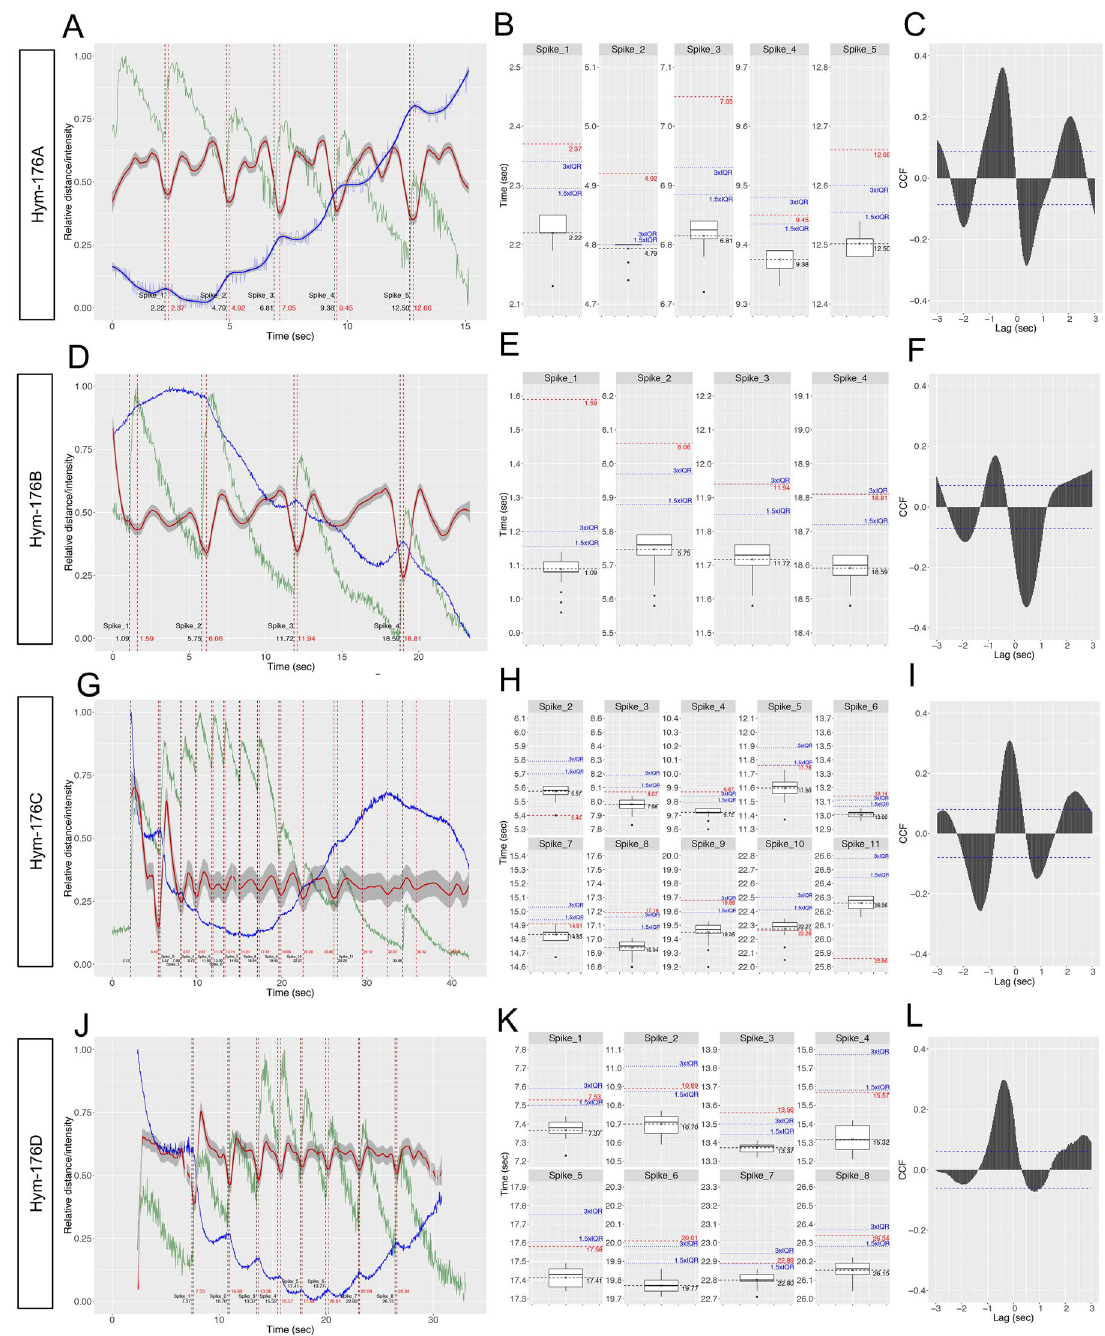
Figure 2. Neuronal activity in the Hym-176 peptidergic neuron subsets is associated with longitudinal contraction. Hym-176A -expressing neuron subsets ( A – C ). Hym-176B -expressing neuron subsets ( D – F ). Hym-176C -expressing neuron subsets ( G – I ). Hym-176D -expressing neuron subsets ( J – L ). Representative neuronal excitation in green; cell #24 in Fig. 1B ( A ), cell #16 in Fig. 1D ( D ), cell #7 in Fig. 1F ( G ) and cell #0 in Fig. 1H ( J ). Vertical dashed black lines show the spike train ( A,D,G,J ), as shown in Fig. 1B,D,F,H, respectively. Change in the distance between the two designated neurons in each subset is shown in blue ( A,D,G,J ); cell #14 and #17 in A, cell #3 and #150 in D, cell #13 and #149 in G, cell #0 and #8 in J. Second-order differences of the distance in red with 95% confidence interval (gray). Starting points of contraction (vertical red dashed line; A: 2.37, 4.92, 7.05, 9.45, 12.66 s; D: 1.59, 6.06, 11.94, 18.81 s; G: 5.40, 8.07, 9.87, 11.76, 13.14, 14.91, 17.19, 19.68, 22.26, 25.86 s; J: 7.53, 10.89, 13.56, 15.57, 17.58, 20.01, 22.89, 26.34 s). Box plot of the spike timing of all tested neurons for each spike (B, E, H, and K). The horizontal dashed black line indicates average spike timing, corresponding to the vertical dashed black line in ( A,D,G,J ). The horizontal dashed red line indicates the start of contraction, corresponding to the vertical dashed red line in ( A,D,G,J ). The horizontal dotted blue line indicates Q3 (3-quantile) + 1.5/3.0 × IQR (interquartile range). Cross-correlation ( C,F,I,L ) between representative neuronal excitation (solid green line) and longitudinal contraction (solid red line) in A, D, G, and J, respectively. The horizontal dashed blue line indicates the 95% confidence interval